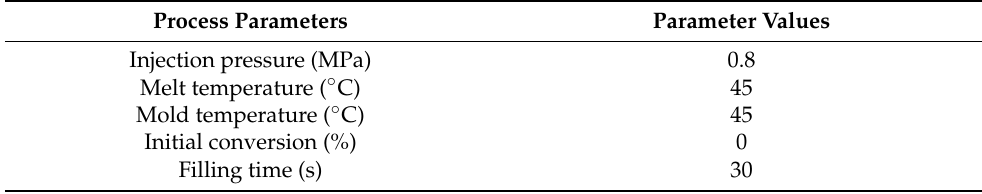
Table 4. The parameters of the filling process in Case 2.